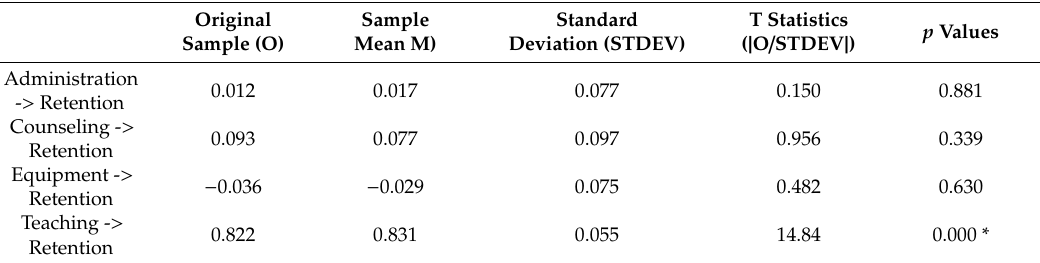
Table 5. Path coe ffi